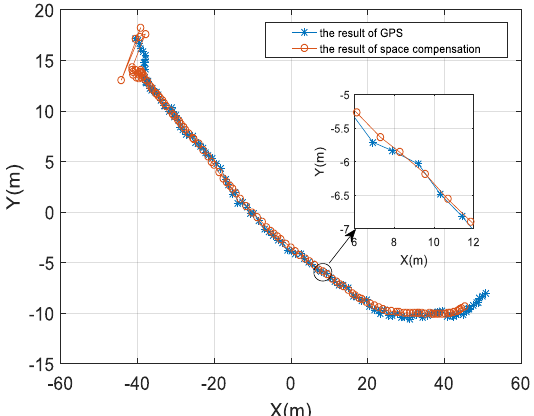
Sensors 2022 , 22 , x FOR PEER REVIEW Figure 14. The analysis result of the modem position. Figure 14. The analysis result of the modem position.